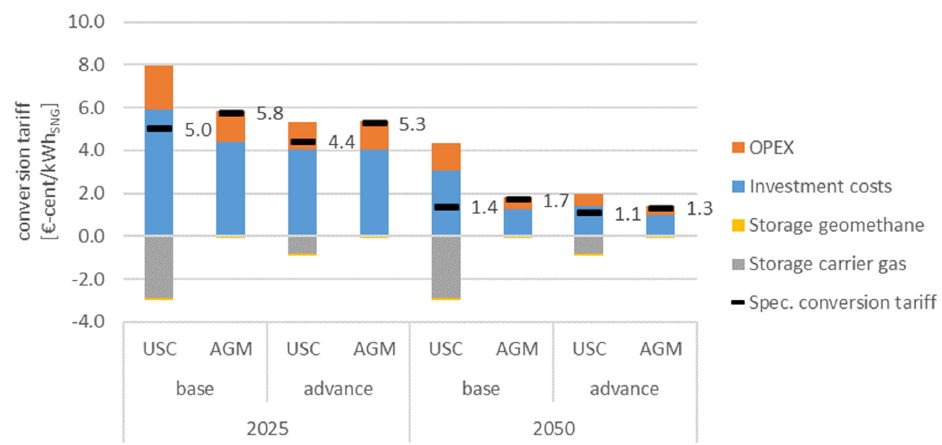
3 /h USC plant and a comparable Figure 12. Cost for conversion for a 100,000 Nm³/h USC plant and a comparable AGM. Figure 12. Cost for conversion for a 100,000 Nm